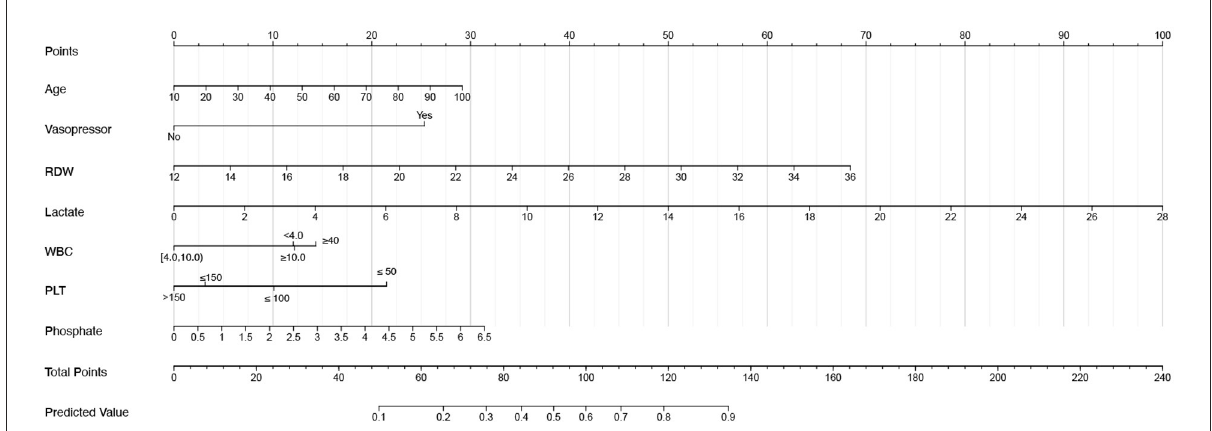
FIGURE3 The nomogram for acute kidney injury patients undergoing continuous renal replacement therapy.